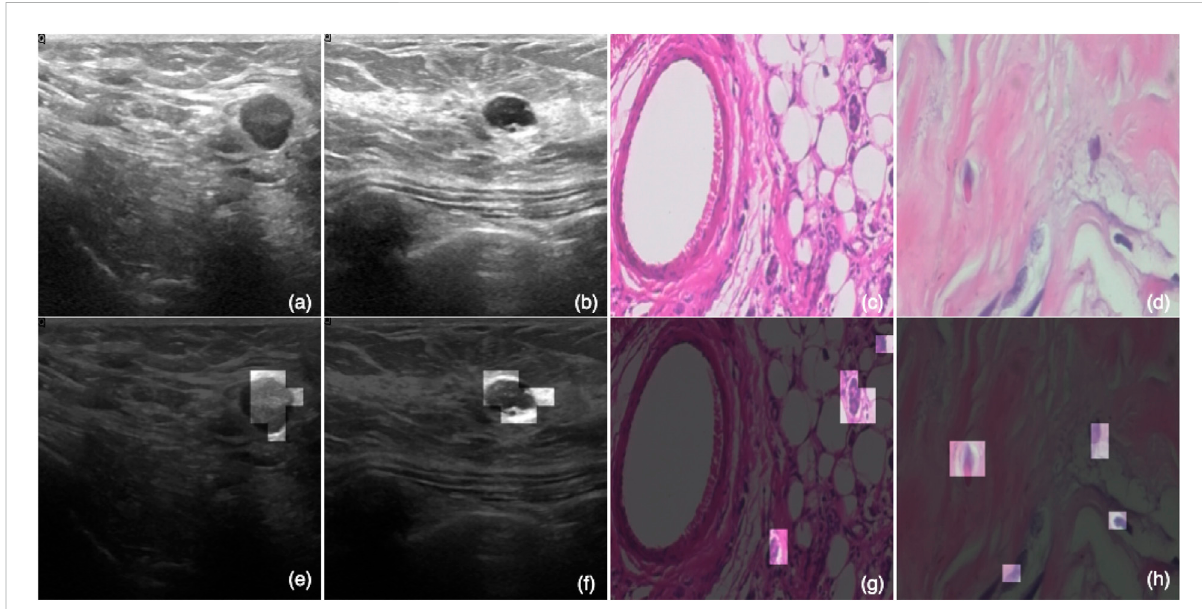
FIGURE 5 Visualized effect of the ATS. Sub fi gures (A,B) are ultrasound images; and (C,D) are histopathology samples. Meanwhile, (E – H) are the same images as (A – D) with the eight most signi fi cant tokens (image patches) kept for each image.